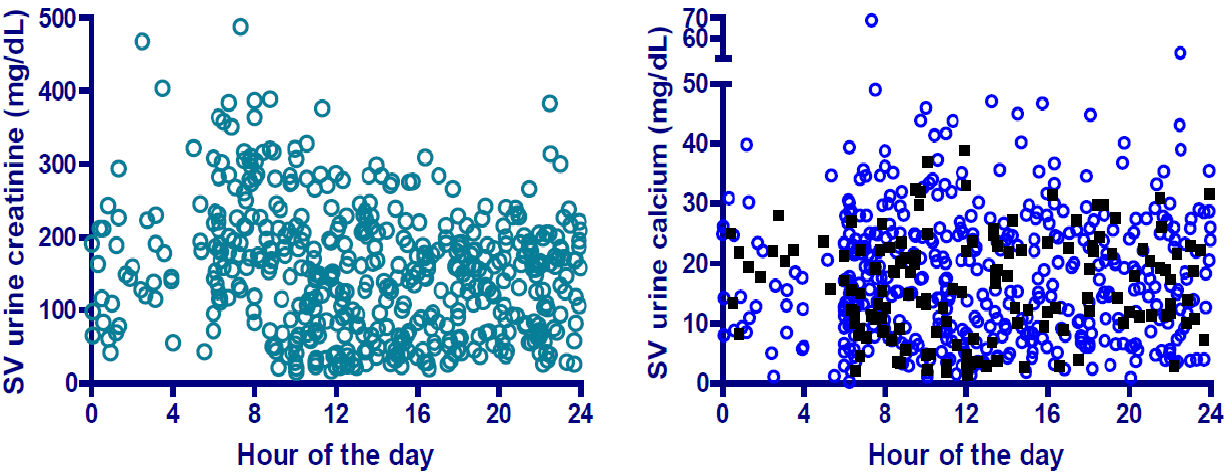
Figure 7. Creatinine (left panel) and calcium (right panel) concentration in single-void (SV) urine samples, by time of day when samples were collected. Some ISS crewmembers were participating in an experiment on bisphosphonate (alendronate) use as a bone loss countermeasure. These data are shown with filled symbols, but did not have a significant effect on calcium